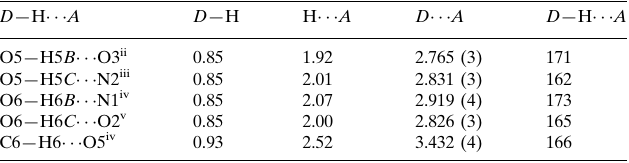
Hydrogen-bond geometry (A˚ , (cid:2)